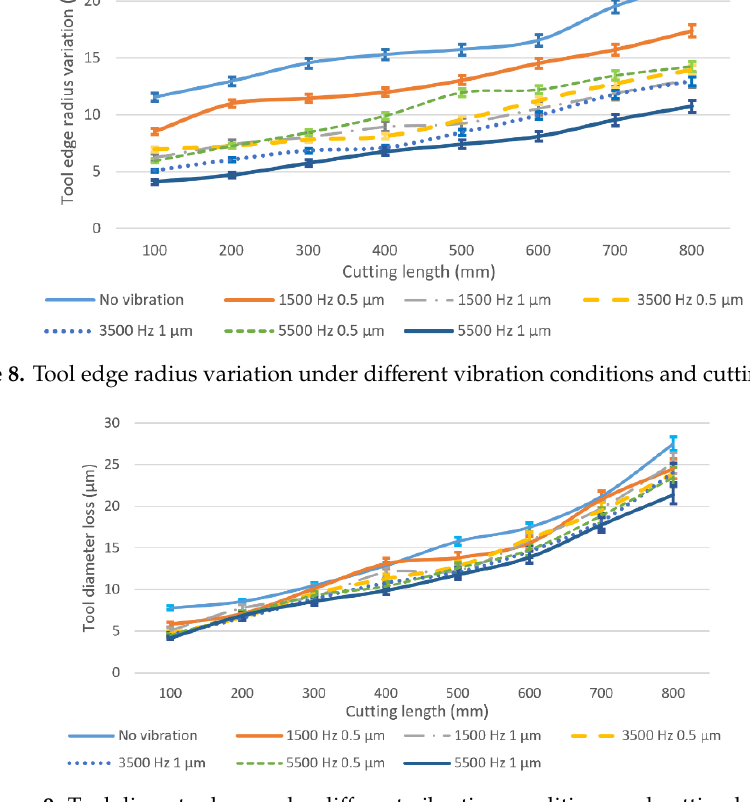
ff erent vibration conditions and cutting Figure 9. Tool diameter loss under different vibration conditions and cutting lengths. Figure 9. Tool diameter loss under di